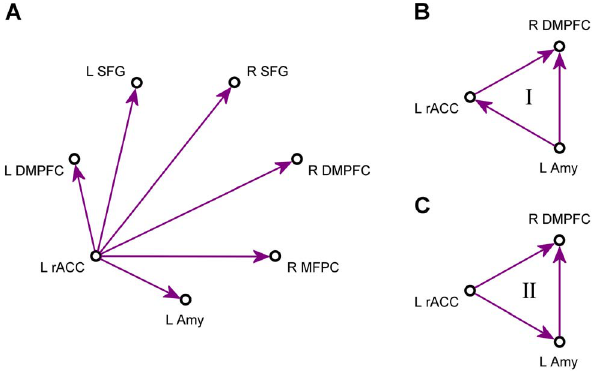
Figure 5 . Schematics of structural models used in the multivariate SVAR analyses. (A) An example of a star model for instantaneous effects. A model of this kind was defined for each of the seven ROIs and examined in the multivariate structural vector autoregression (SVAR) analysis. (B,C) Two models for instantaneous effects, Model I and Model II, that provided the best x 2 fits to the experimental group data in the SVAR analyses for the system of three ROIs. A total of 24 structural models were optimized and compared for the system consisting of the left amygdala, the left rACC, and the right DMPFC (see text for details).